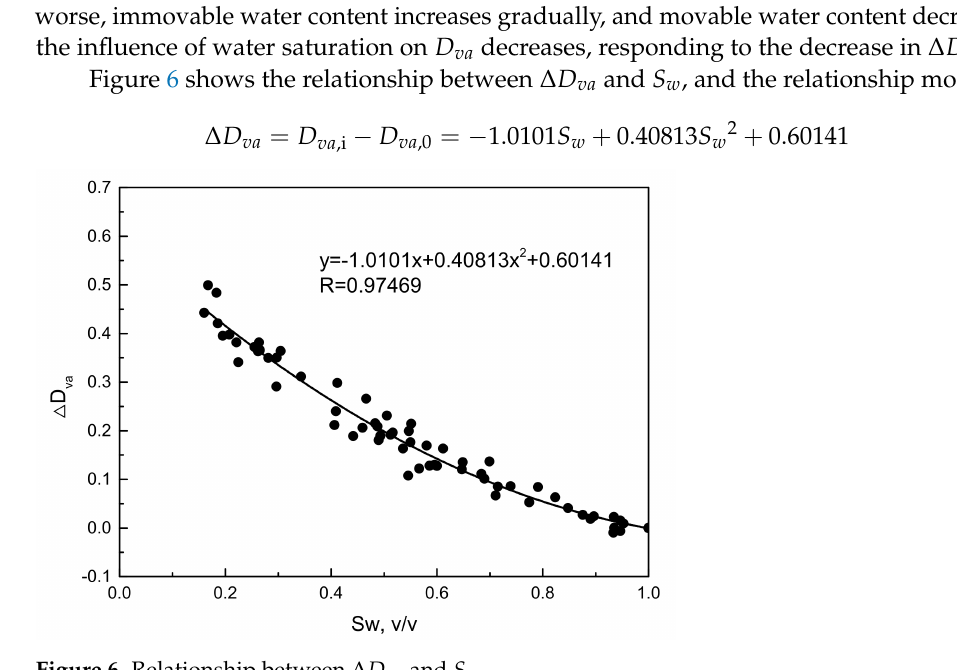
Figure 6. Relationship between ∆ D va and S w